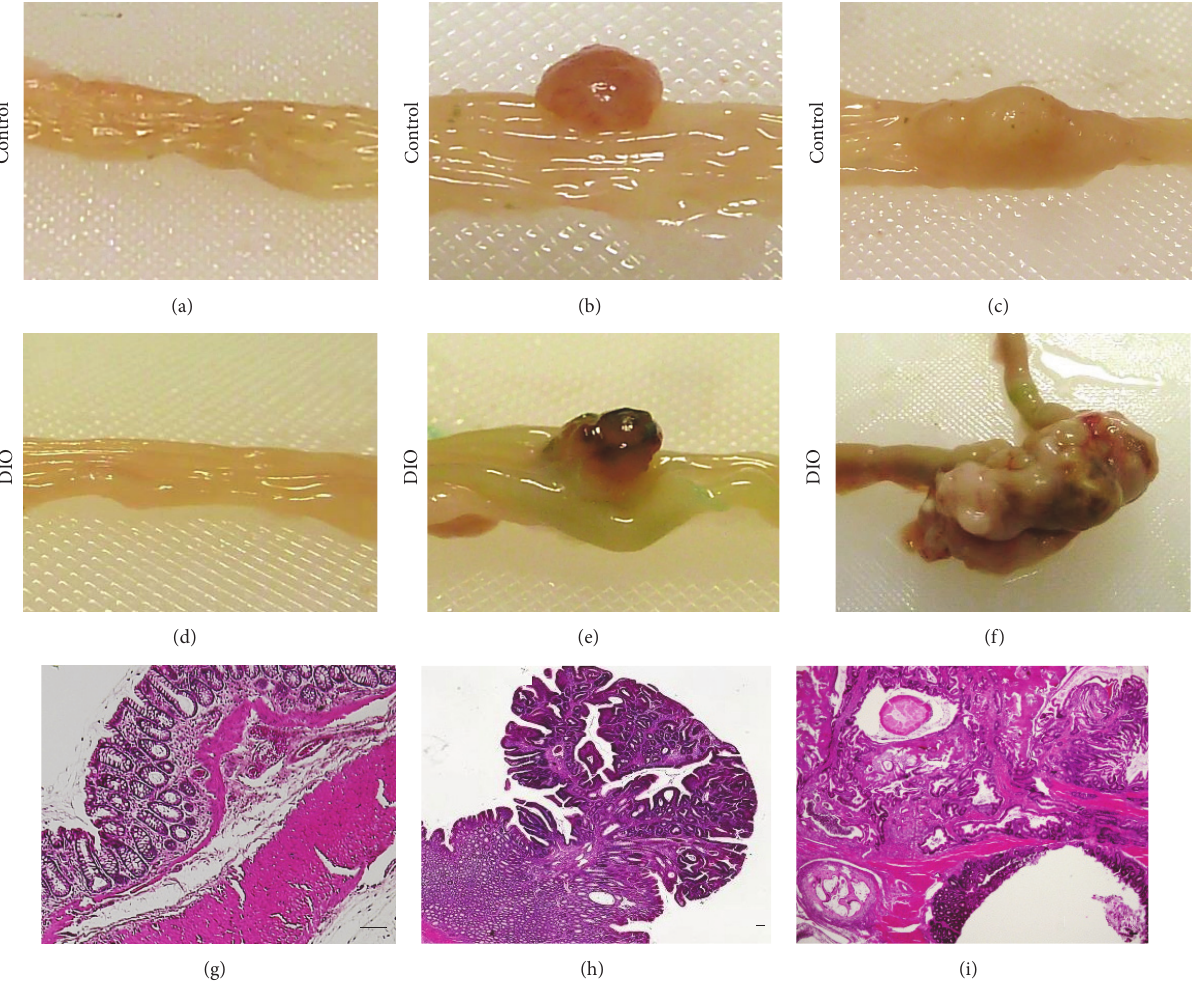
Figure 3: (a–f) Macroscopic observation of normal colon tissue, colorectal adenoma, and colorectal adenocarcinoma from azoxymethane- (AOM-) treated normal weight rats (a–c) as well as diet-induced obese (DIO) rats (d–f). (g–i) Representative histopathology of healthy colon tissue (g), colorectal adenoma (h), and colorectal adenocarcinoma ((i) scale bar, 100 𝜇